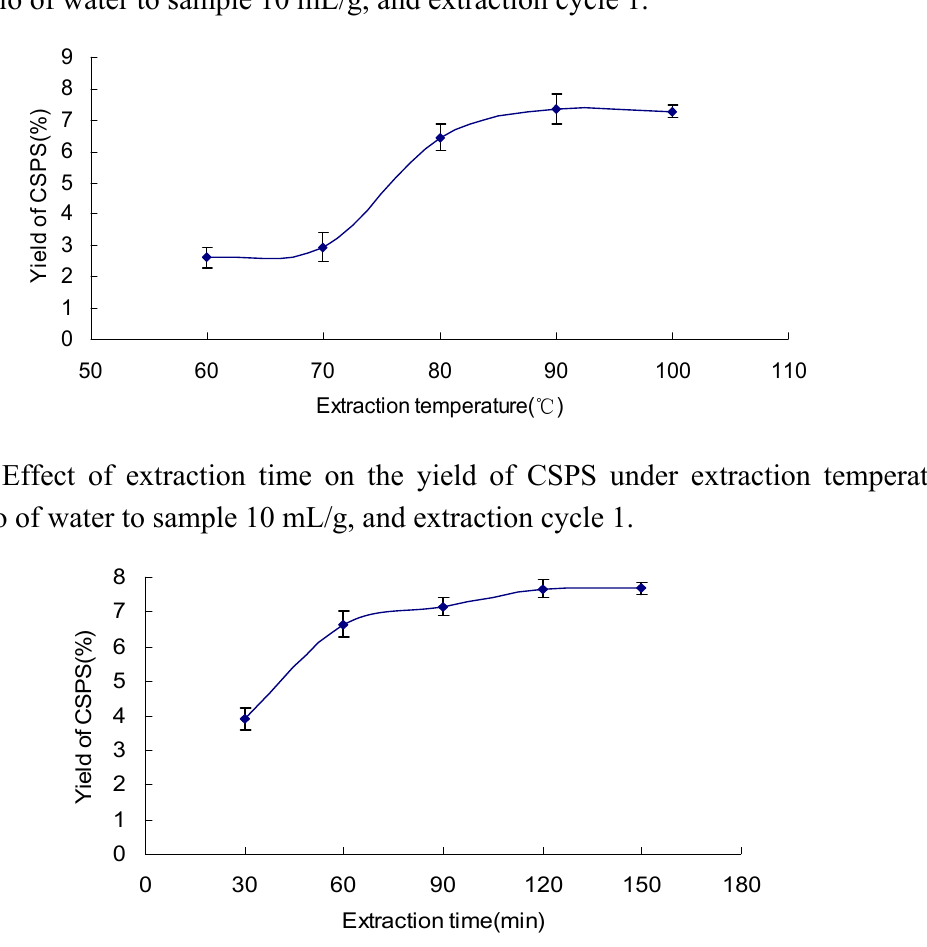
Figure 1. Effect of extraction temperature on the yield of CSPS under extraction time 60 min, ratio of water to sample 10 mL/g, and extraction cycle 1.